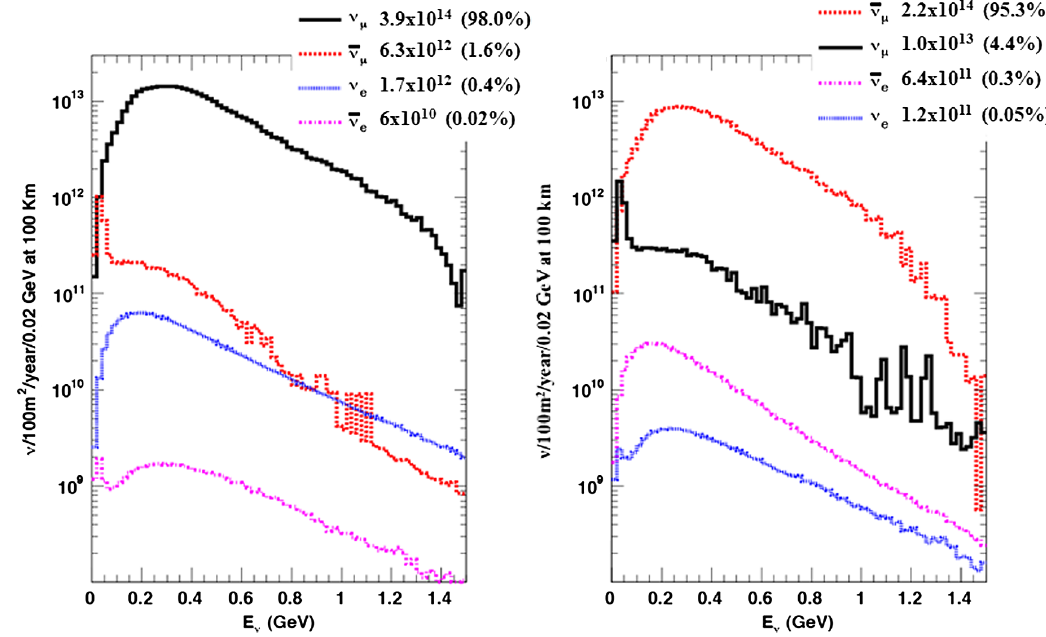
FIG. 7. The composition of the neutrino beam produced by the Super Beam